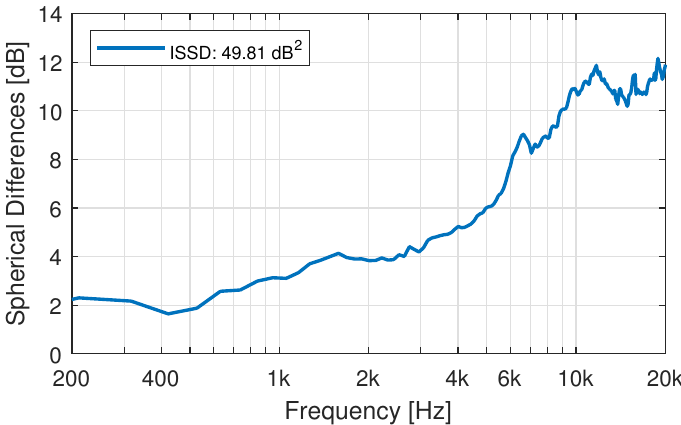
Figure 10. Spherical differences between measurement and simulation of participant 15.